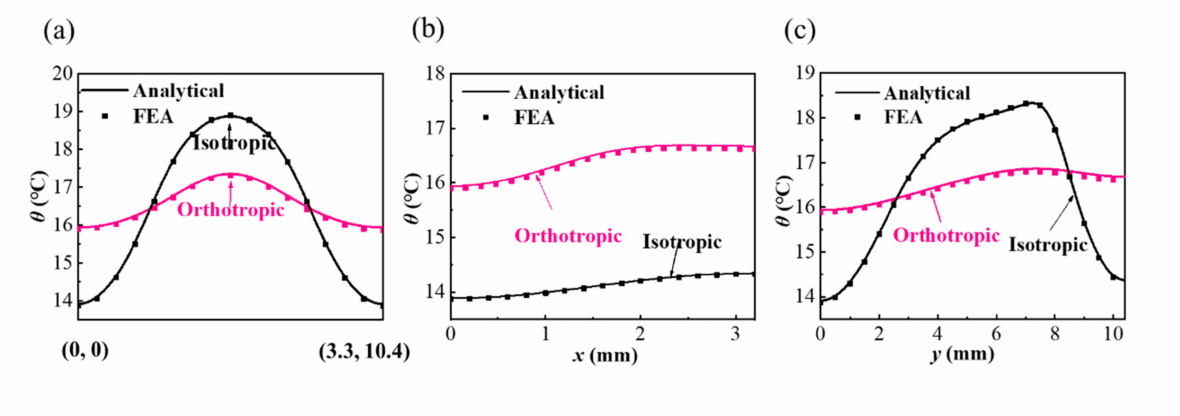
Figure 4. The comparisons of temperature increase along ( a ) the line from (0, 0) to (3.2, 10.4), ( b ) y = 2.5 and ( c ) x = 0 on the bottom surface a quarter of unit cell between the analytical results and FEA.